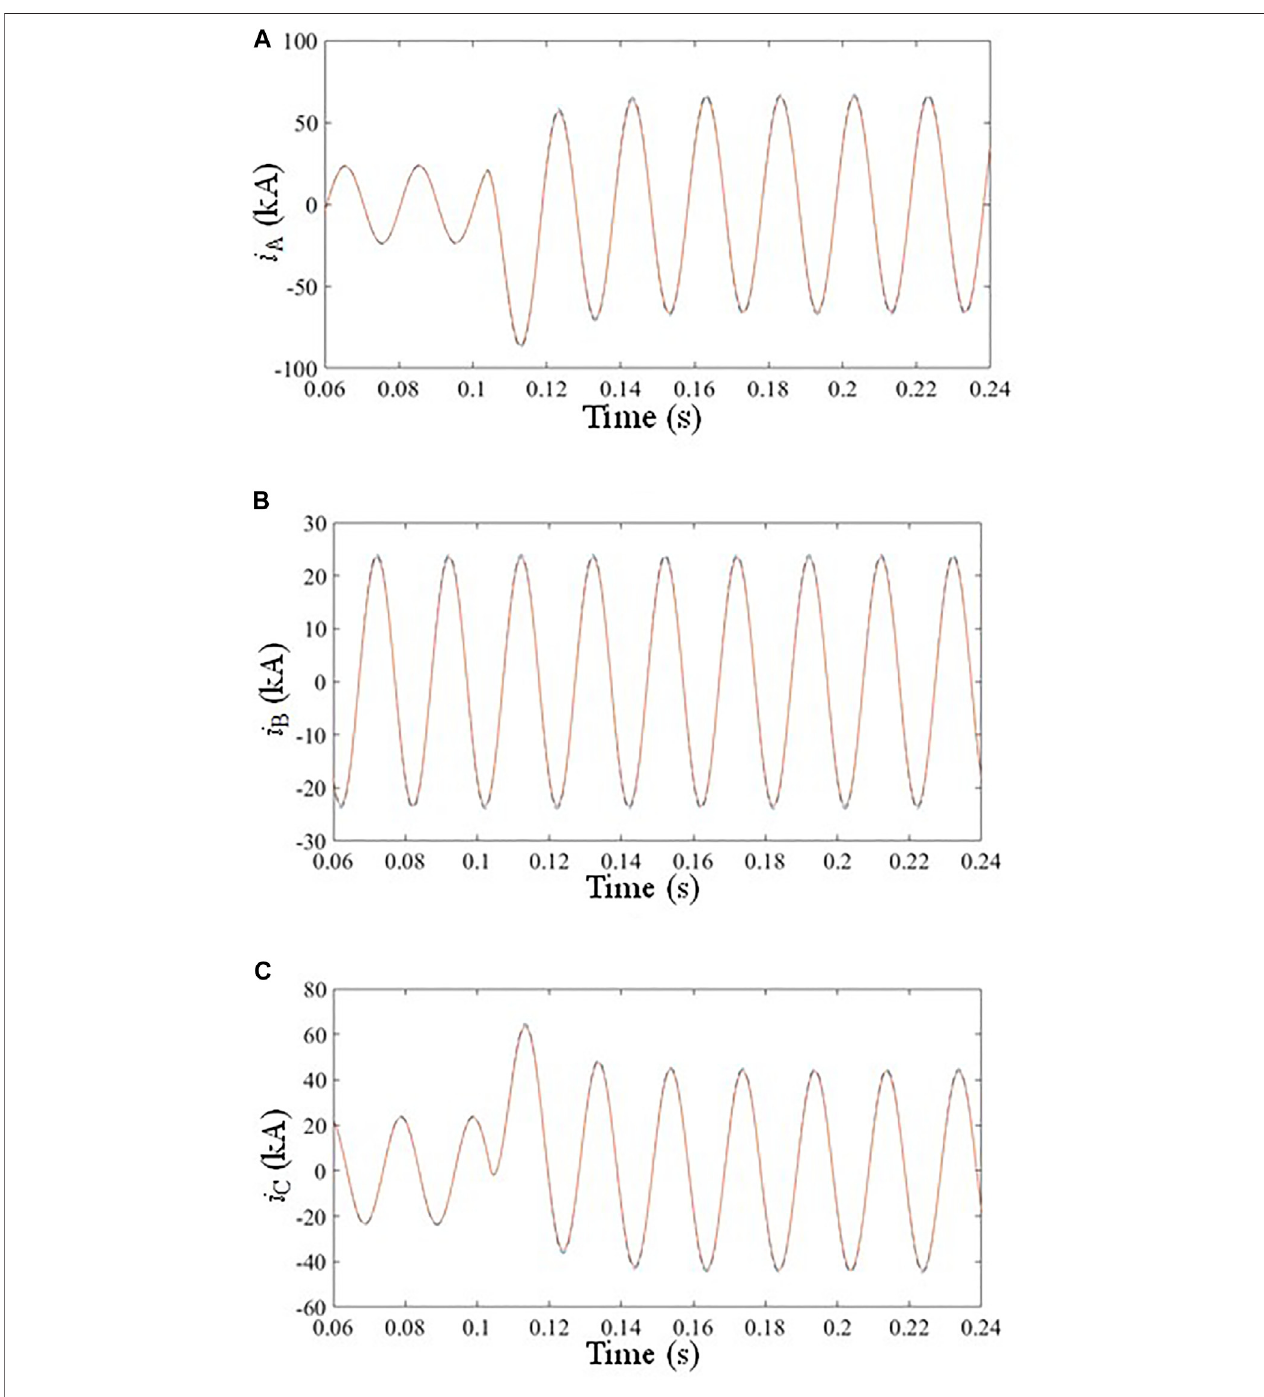
FIGURE 9 | Three-phase current waveform on the N side under CA phase-to-phase fault. (A) Current of phase A, (B) Current of phase B, (C) Current of phase C.